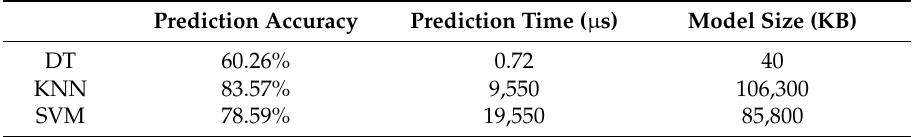
Table 8. General accuracy of each algorithm with the proposed 14